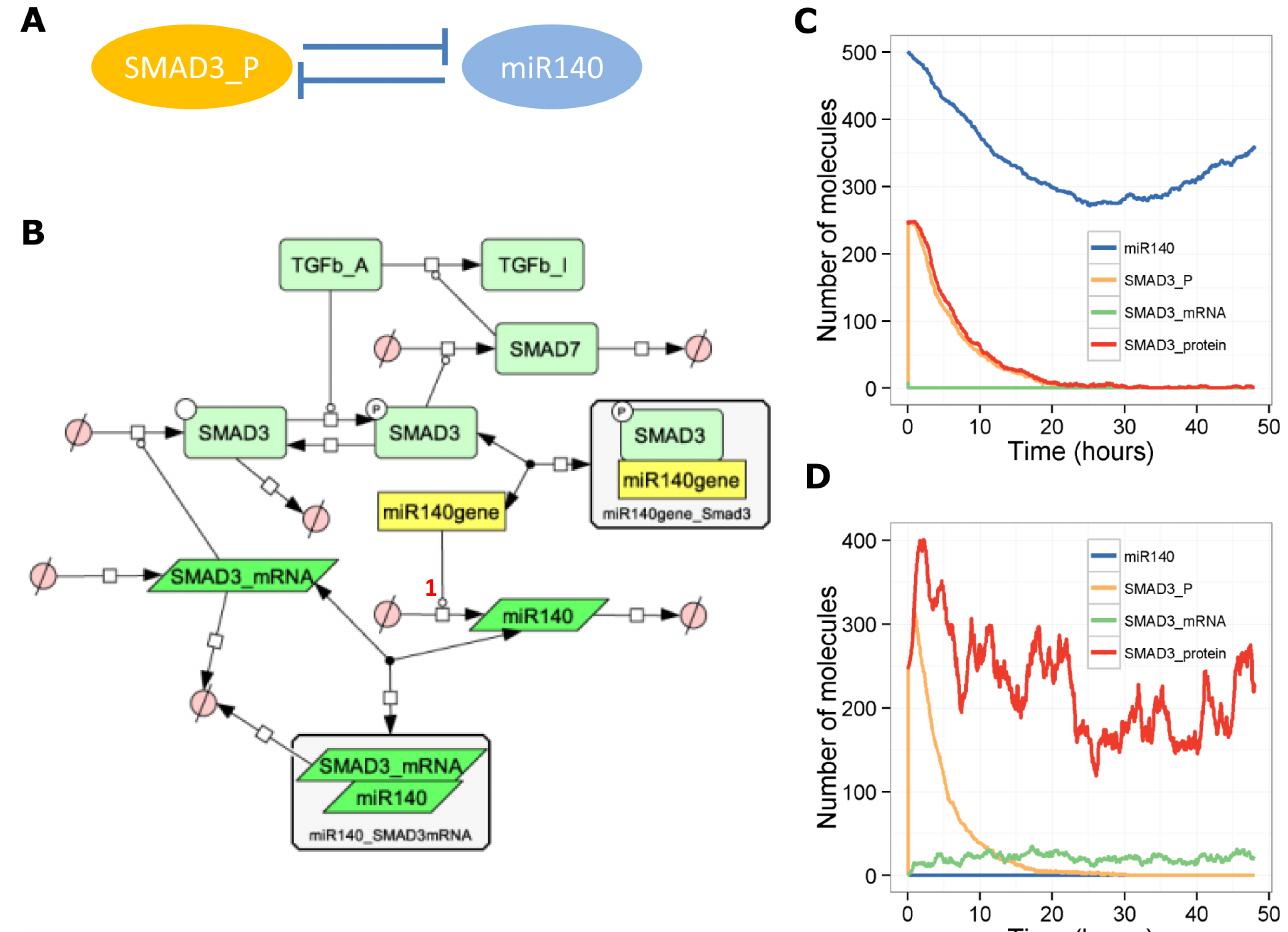
Fig 2. Model of the involvement of miR-140in SMAD3 signalling. A , Network motif showingpositive feedback. B , Diagramof full model. C - D, Output from one stochastic simulationwith miR-140present (miR140= 500 initially, k synmiR140 = 0.0018s -1 ) (C) or without miR-140(miR140 = 0 initially, k synmiR140 = 0.0 s -1 ) D . Key for B : TGFb_A–active TGF- β , TGFb_I–inactive TGF- β , miR140_SMAD3mRNA–SMAD3mRNA bound by miR140to inhibit its translation.